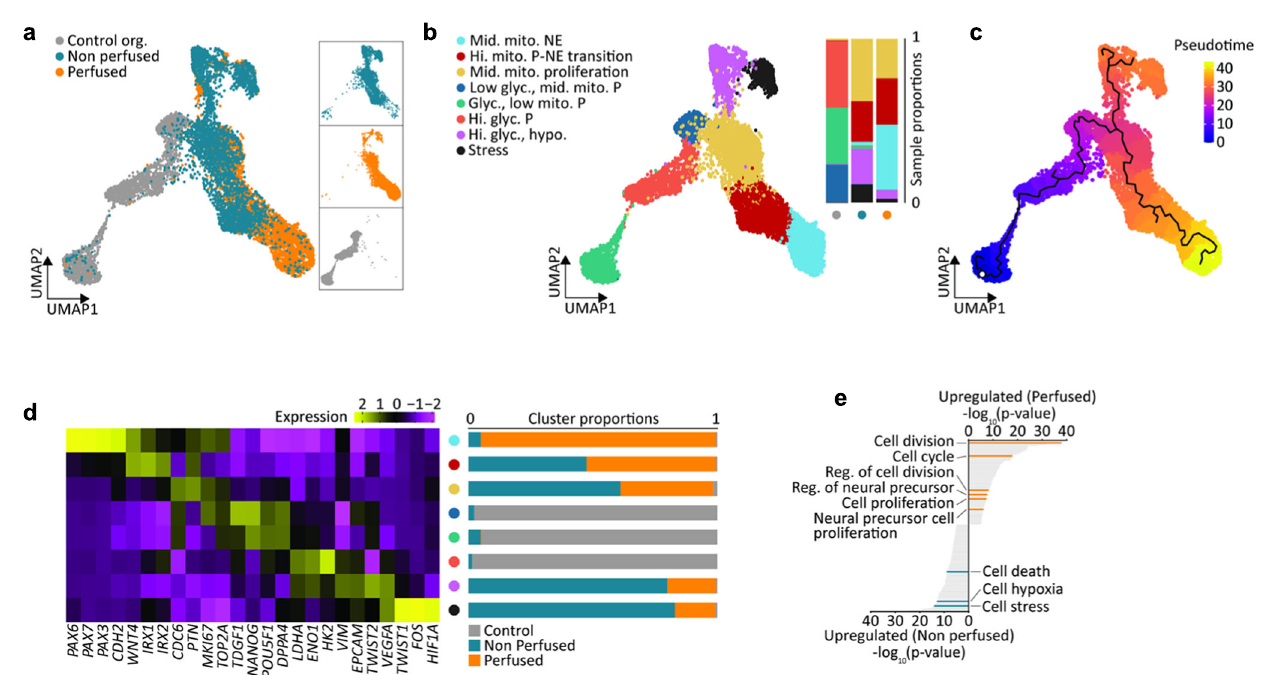
Fig. 2 | Transcriptomic changes upon perfusion. a Combined dataset UMAP (control, non-perfused and perfused samples). b Combined dataset UMAP with neuroepithelial cells (NE), pluripotent-neuroepithelial transitioning cells (P-NE), proliferatingcellswithmediummitochondrial(mito.)content,pluripotentcells(P) with low glycolysis (glyc.) and medium mitochondrial content, glycolytic plur- ipotent cells with low mitochondrial content, highly glycolytic pluripotent cells, a